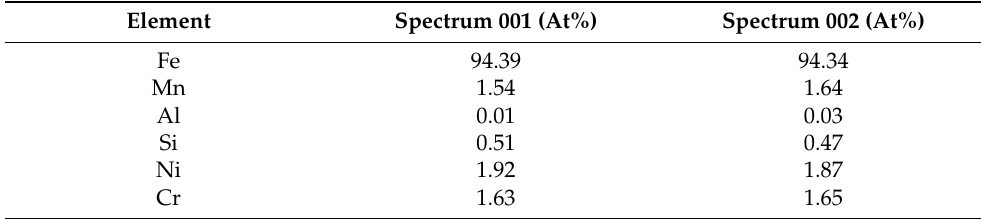
Figure 10. Fractographs of similar welds of 6252 Armor steel. ( a ) 40× ( b ) 500× ( c ) 1000× ( d ) 2000×. Table 5. Elemental composition.